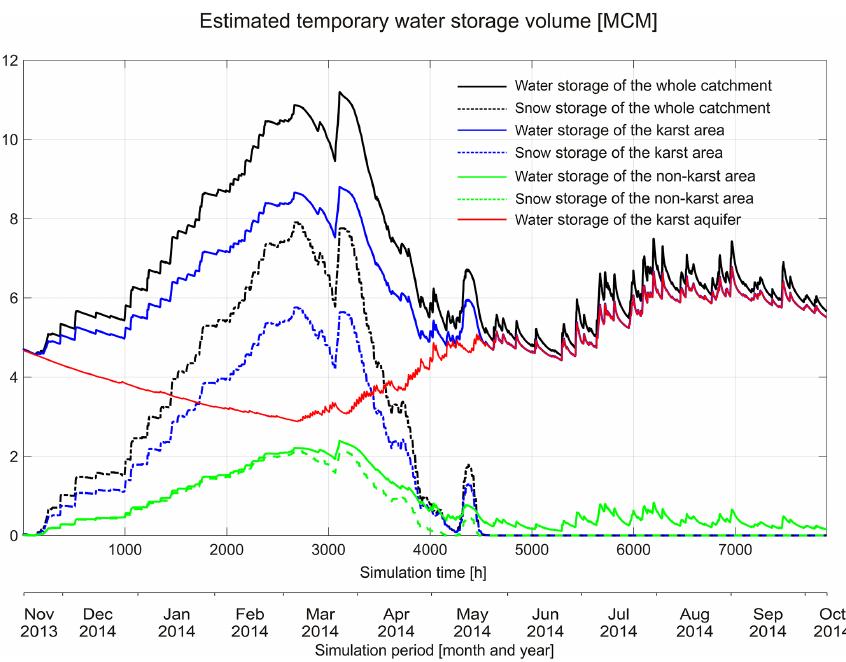
Figure 6. Estimated temporary water storage volumes for the whole catchment, karst area, non-karst area and karst aquifer for the period November 2013–October 2014 on an hourly time step in million cubic meters (MCM).